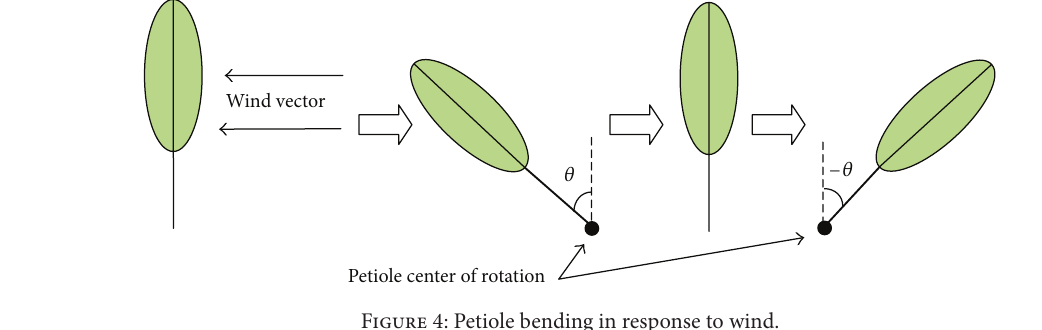
Figure 4: Petiole bending in response to wind.